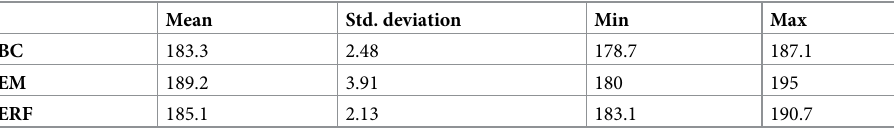
Table 4. Point cloud density (points/mm 2 ) of all stone models.